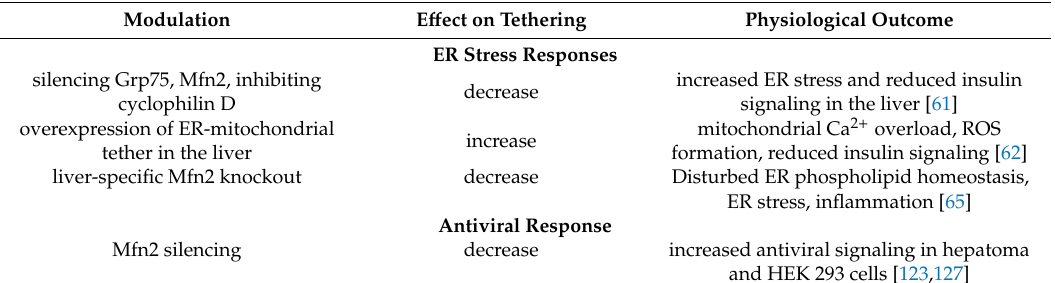
Table 1. E ff ects of modulating ER-mitochondrial tethering on ER stress and antiviral responses.